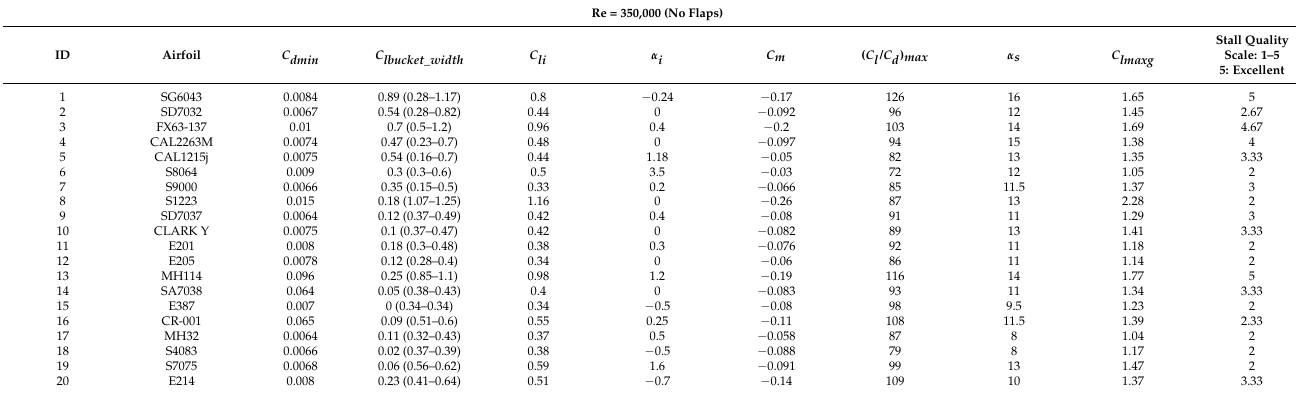
Table 8. Measurements of interest at Re = 350,000 and no flap usage.